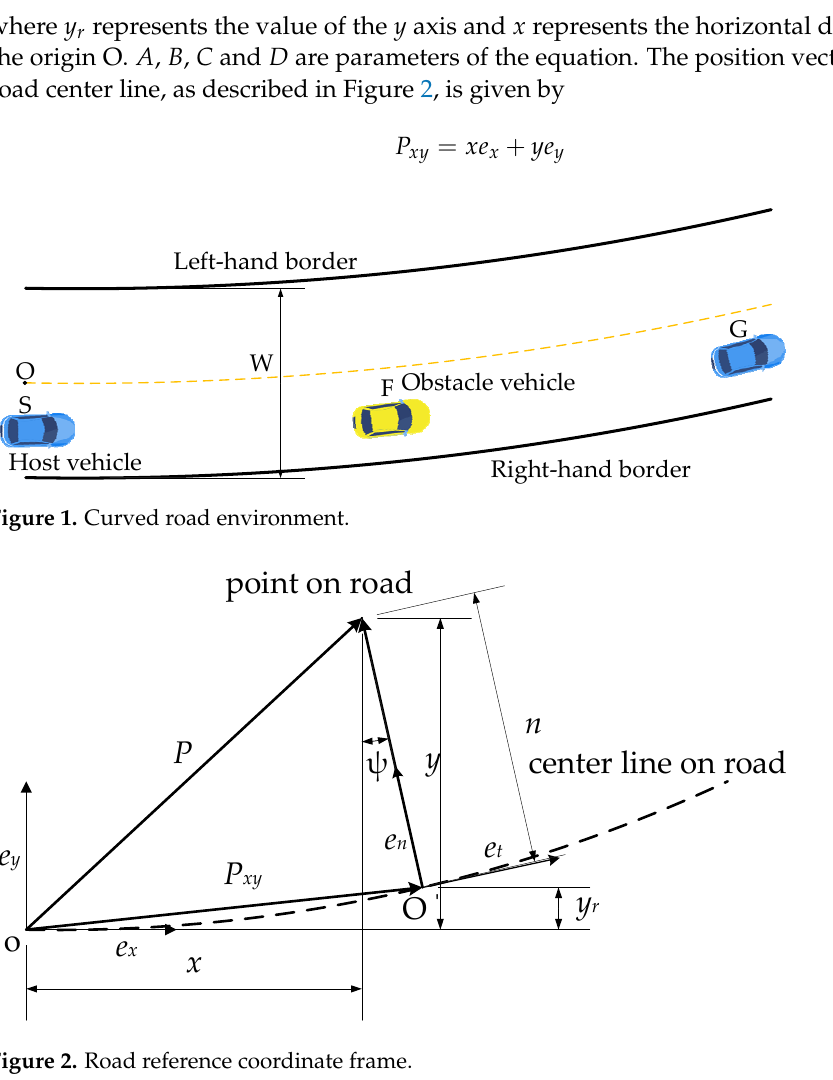
Figure 2. Road reference coordinate frame. Under the boundary conditions , the unit tangent vector and unit normal vector of a point on the center line of the road can be represented by Equations (3) and (4), respectively. Thus, the points on the left and right boundaries of the